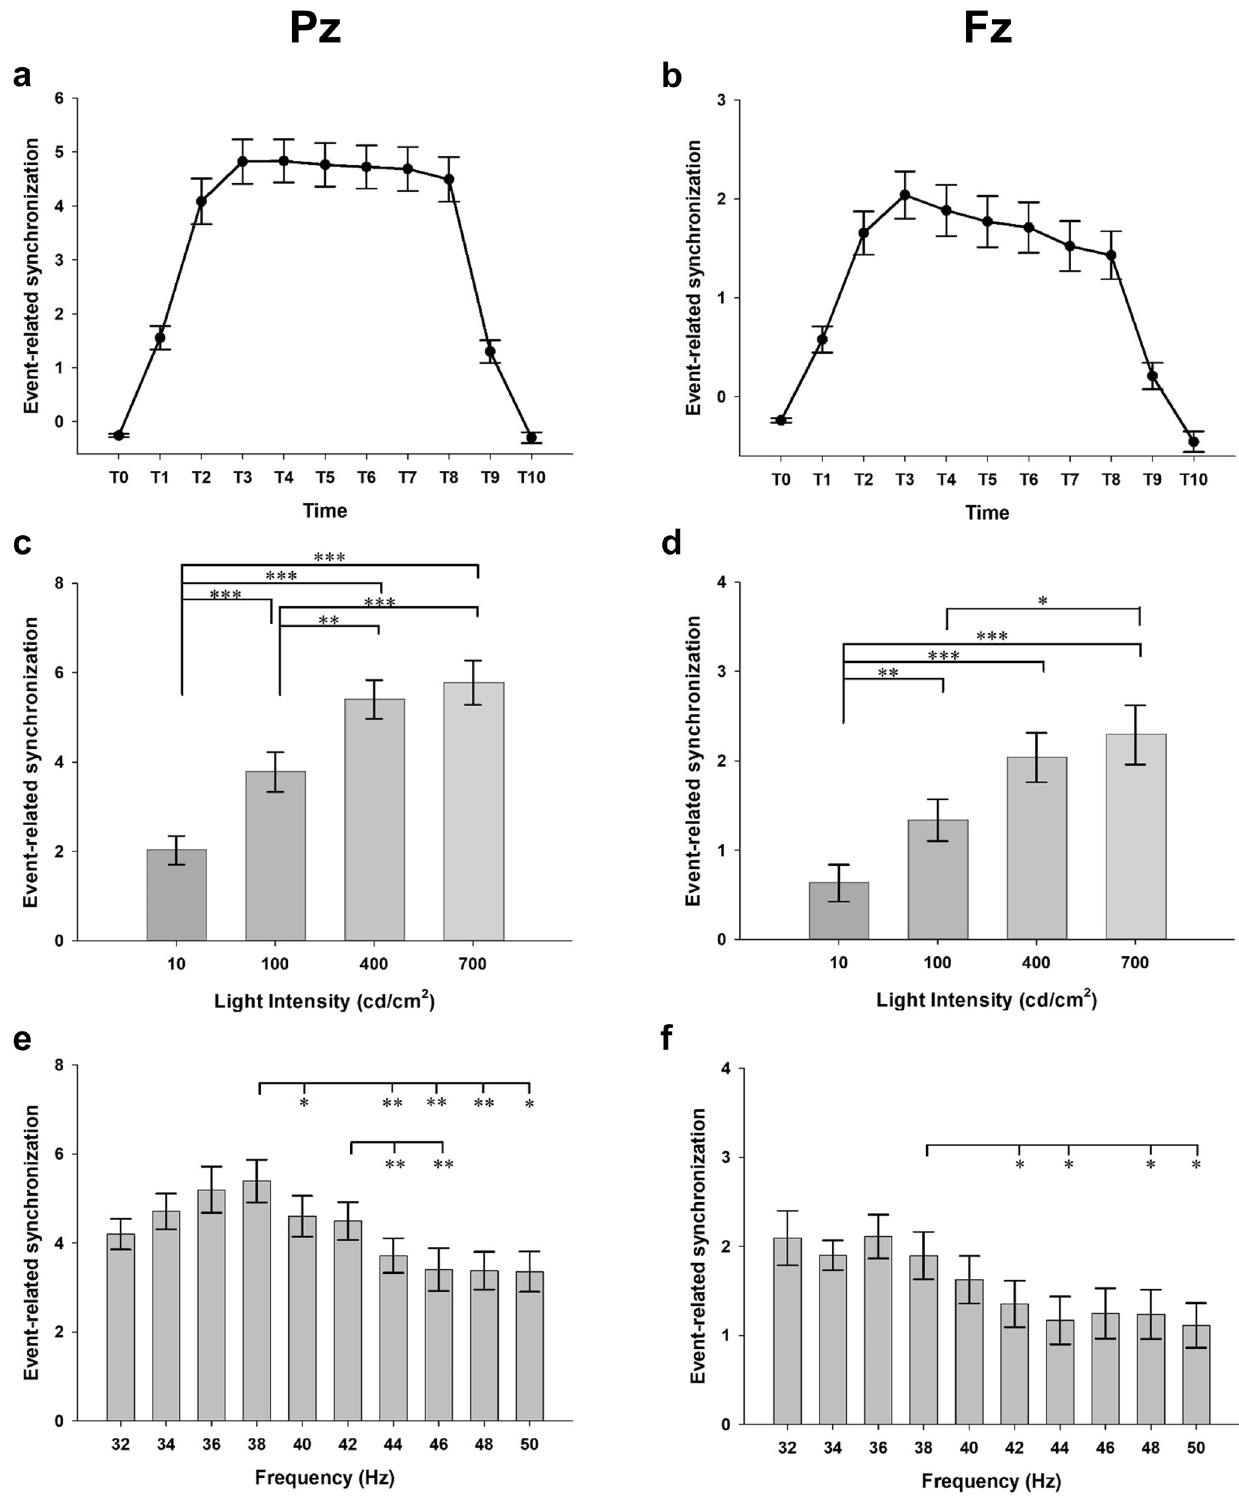
Figure 3. Plots of results of the repeated measures ANOVA in the EXP-2. Averaged event-related synchronization of steady-state visually evoked potentials induced by flickering light stimulus (FLS) in the second experiment. T0–T10 indicates 250 ms time windows from 250 ms before the onset of FLS to 500 ms after the offset of FLS. The main effect of the time window on ERS at Pz ( A ) and Fz ( B ). The main effects of the luminance intensity of FLS on ERS at Pz ( C ) and Fz ( D ). The main effect of flickering frequency of FLS on ERS at Pz ( E ) and Fz ( F ). Error bars indicate standard errors. * p < 0.05, ** p < 0.01, *** p < 0.001, by repeated measures analysis of